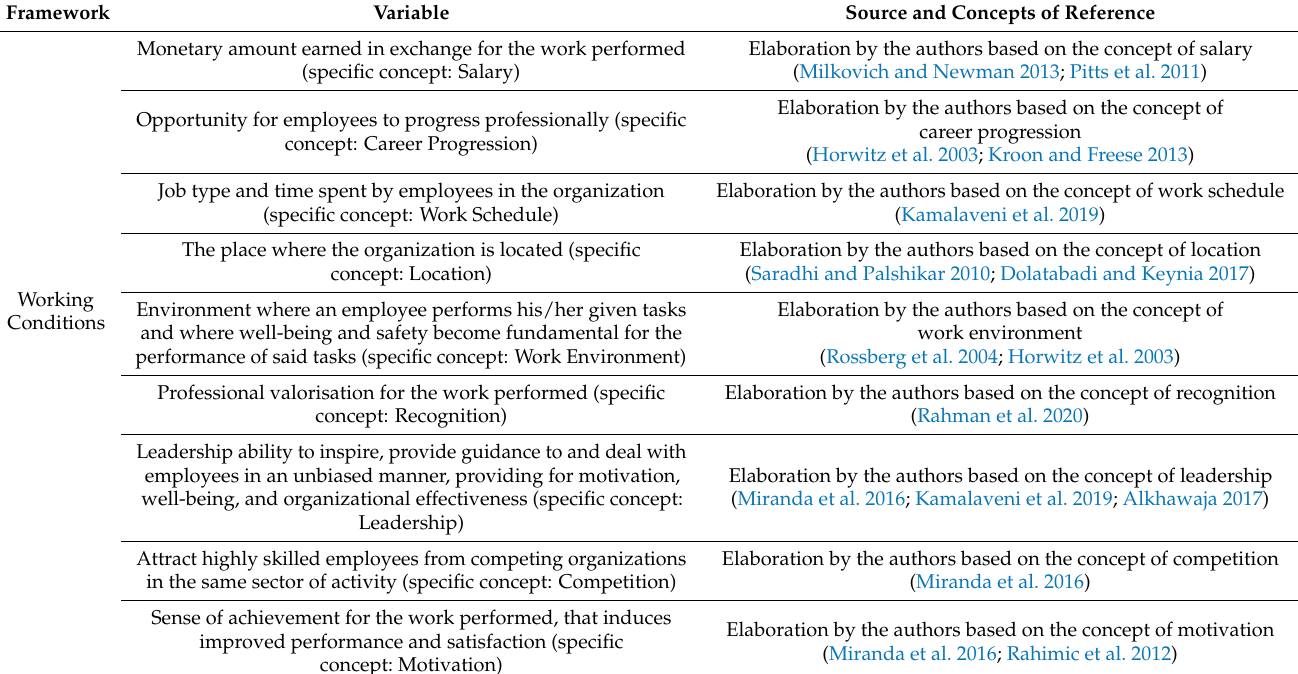
Table 2. Selected variables to assess perceptions of the causes of churning of human